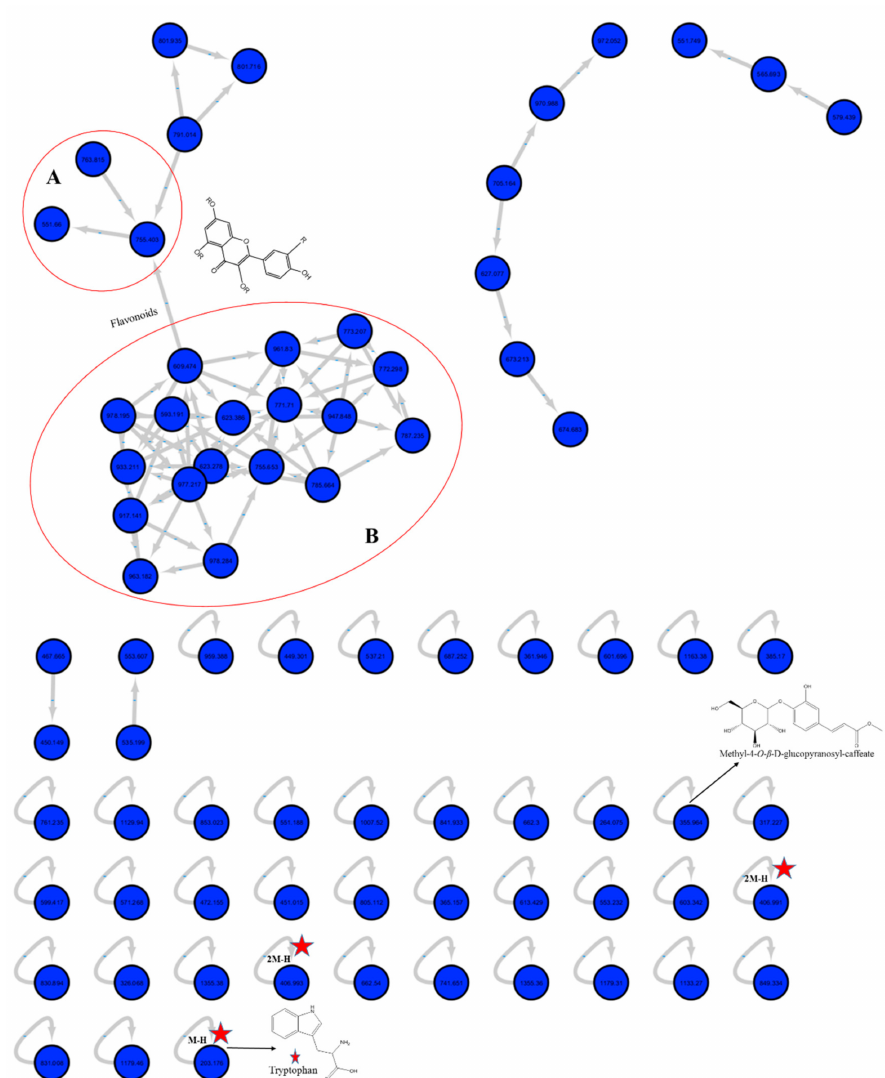
Figure 2. Full molecular networking from M. sinaica aerial parts fraction created using MS / MS data in negative mode. Nodes are labeled with parent mass. Clusters A and B indicate the O -glycosidic flavonols and their